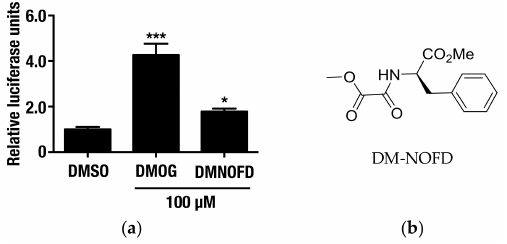
Figure 4. ( a ) Evaluation of HIF activation using an FIH-1 inhibitor (DM-NOFD). SKN:HRE-MLuc cells were treated with DMSO (1%), DMOG (100 µ M) or DM-NOFD (100 µ M) for 24 h under hypoxic conditions (3% O 2 ). The degree of induction is presented as relative luciferase units, with the value from DMSO-treated cells set as 1 for each treatment. Experiments were performed in triplicate. Data are means ± SEMs ( n = 3). The statistical significance of results compared with data from the control group was calculated using one-way ANOVA with Newman-Keuls multiple-comparison tests. * p = 0.05 to 0.01; *** p < 0.001; ( b ) Chemical structure of